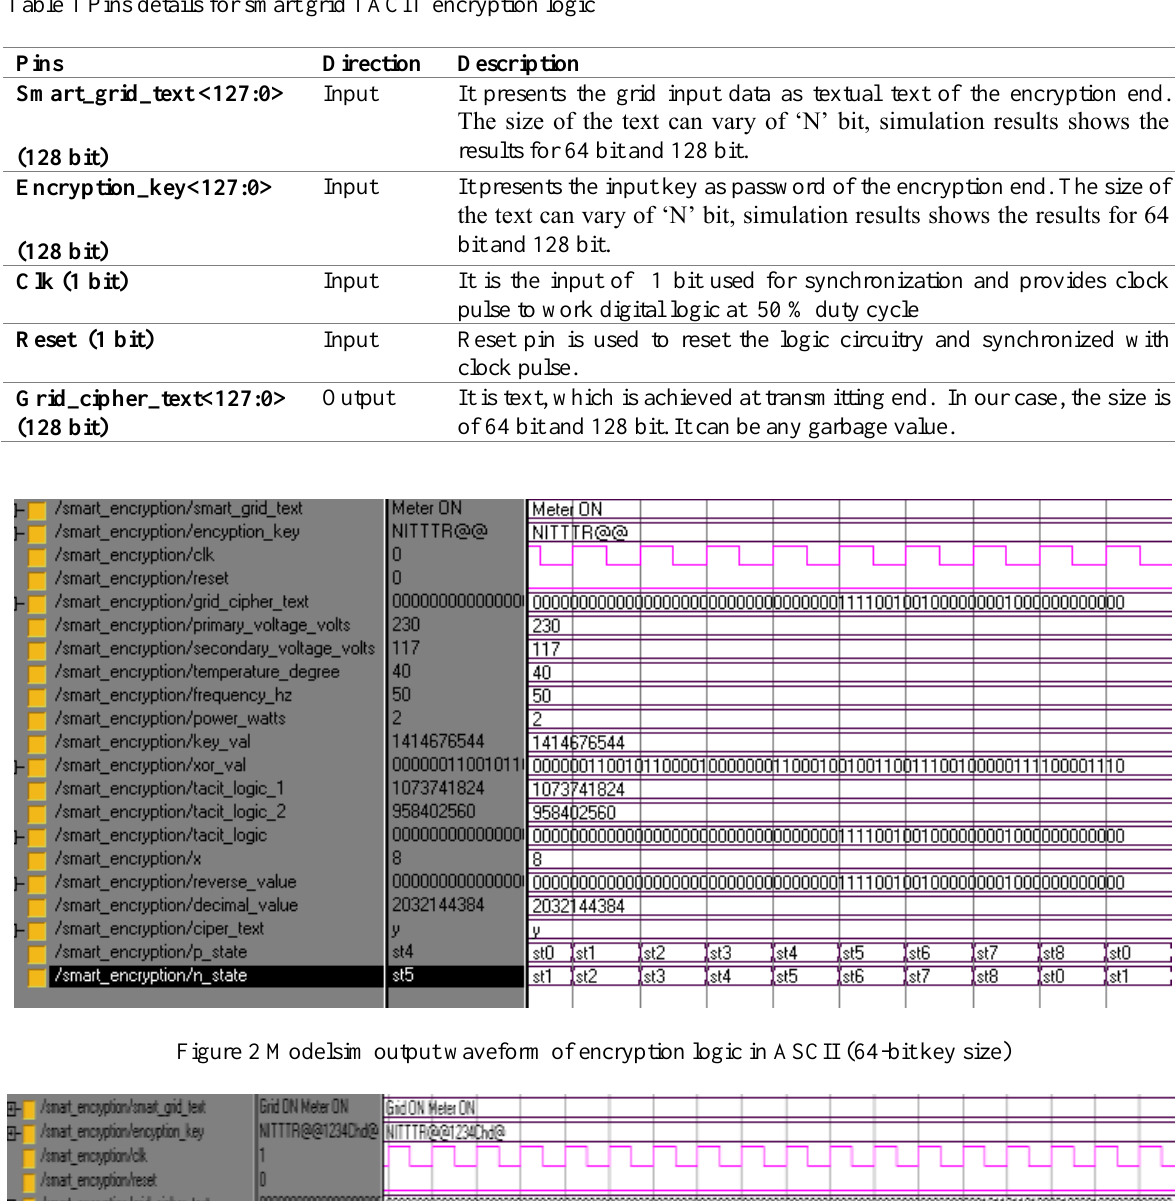
Table 1 Pins details for smart grid TACIT encryption